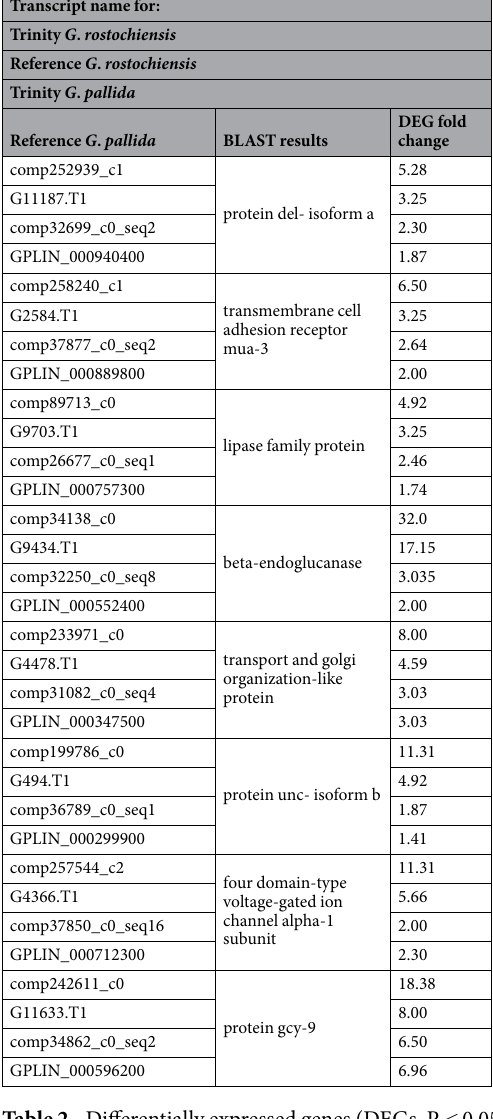
Table 2. Differentially expressed genes (DEGs, P < 0.05, FDR < 0.1) up-regulated in hydrated cysts common to both G . rostochiensis and G . pallida in both de novo and reference